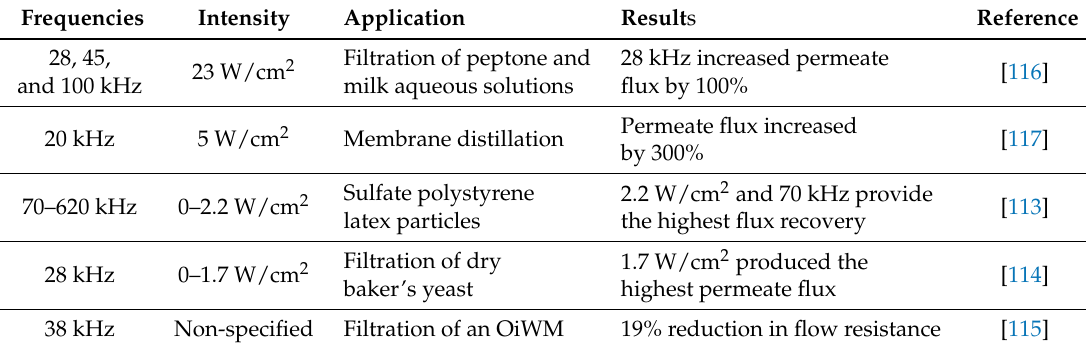
Table 3. Ultrasonic case studies for membranes